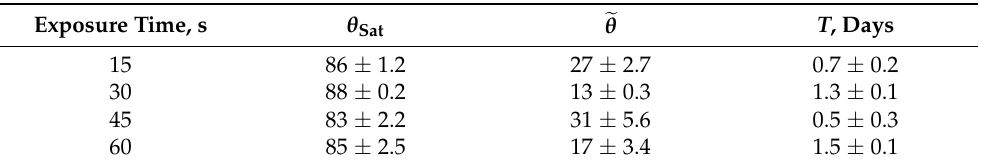
Table 4. Parameters of the exponential fitting of the kinetics of hydrophobic recovery following the radiofrequency plasma treatment of PVC.